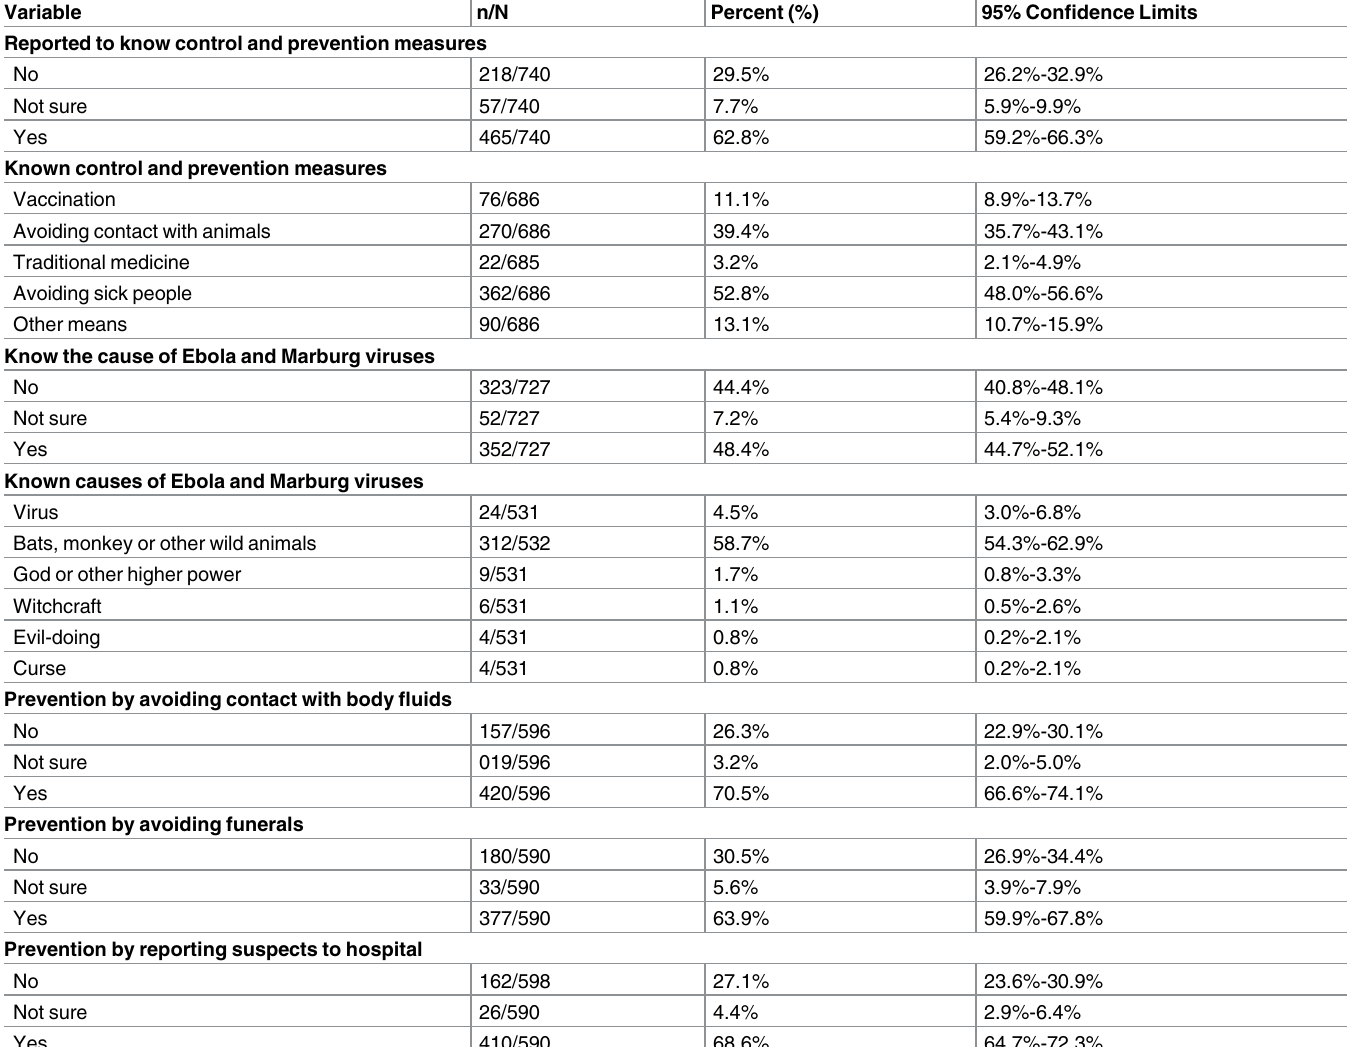
Table 2. Knowledge on control and prevention of Ebola and Marburg virus